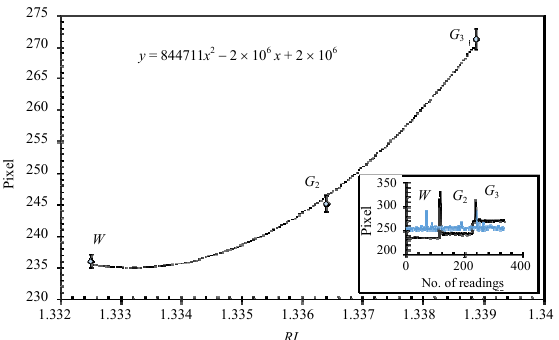
Fig. 17 Plot of dip positions with respect to RI for Channel 1. The inset shows the recording of response from Channel 1 (dark) and Channel 2 (light).